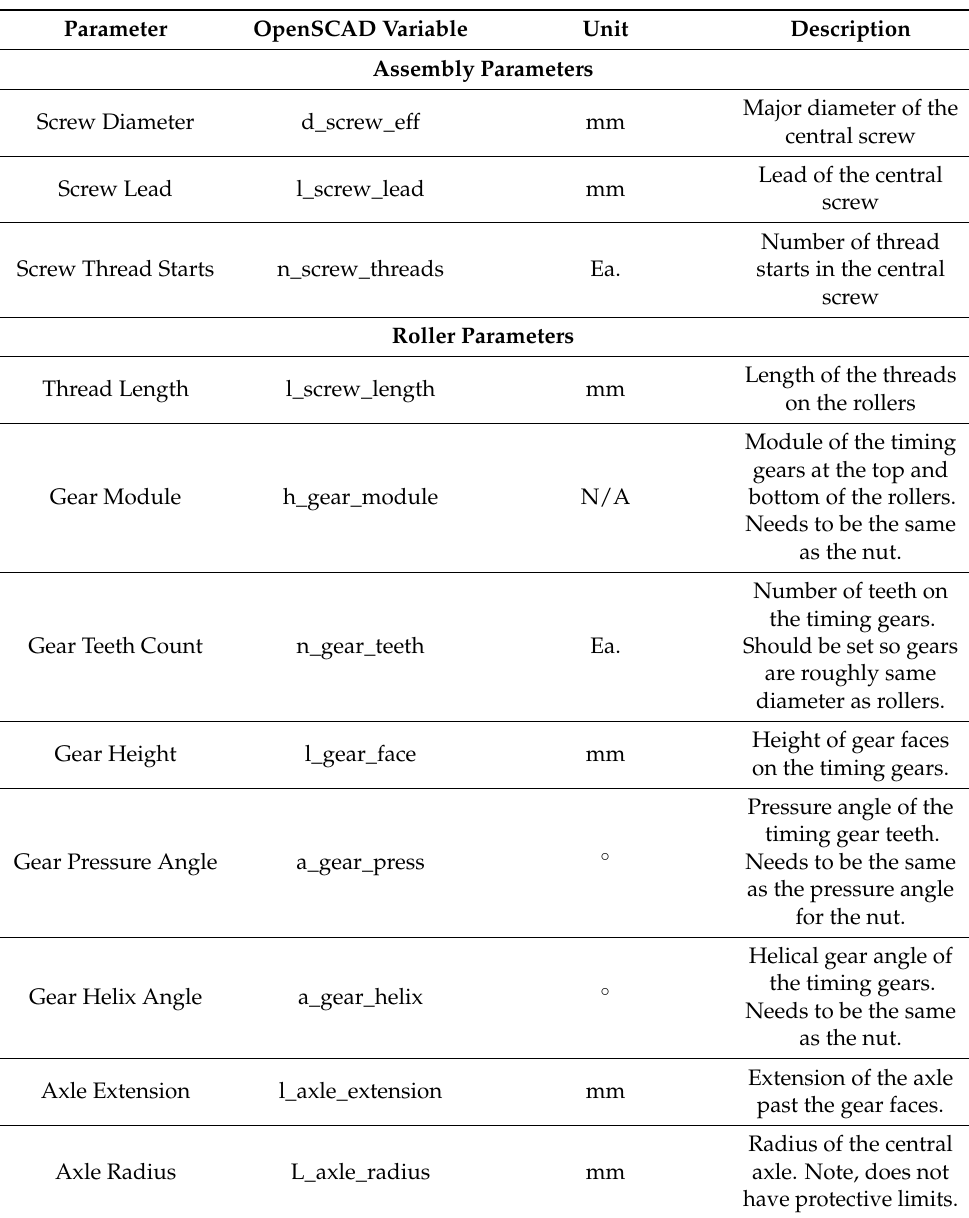
Table A4. OpenSCAD roller